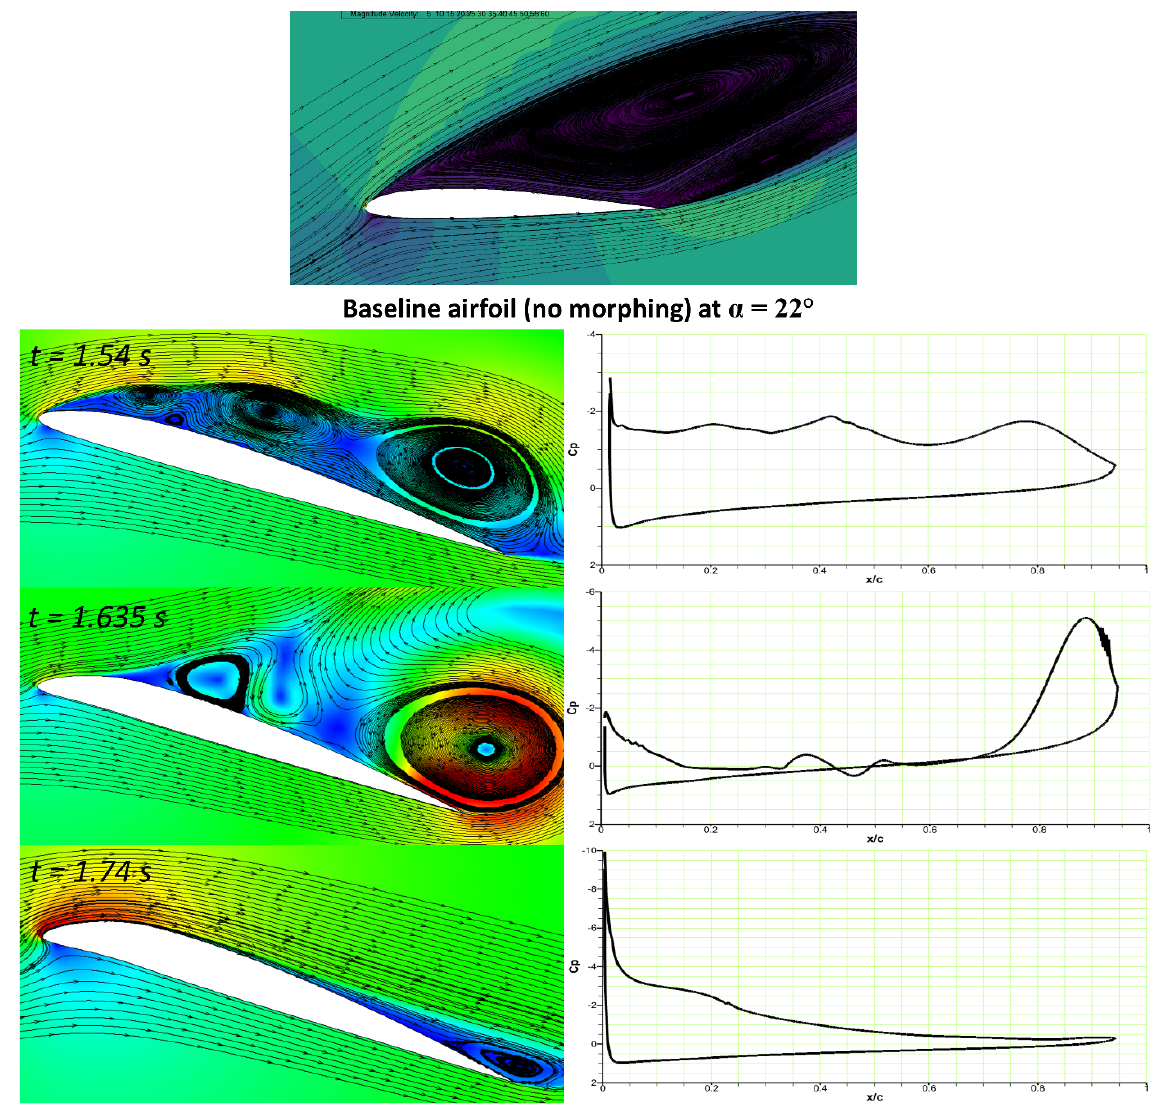
Figure 14. Streamline velocity contours at different time steps on a variable morphing leading edge and the Cp distribution at 22° angle of attack.